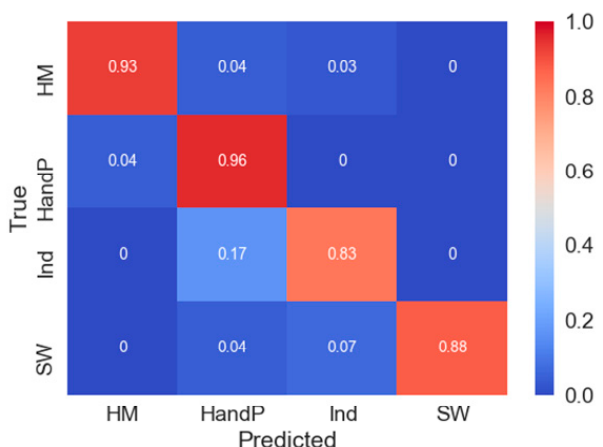
Figure 5. Application of CAM information with truncated dataset. Confusion matrix demonstrating retained classification ability of the truncated dataset, following truncation of the 4-SW dataset from 1002 in length to 400 (where the first 502 and last 100 data points were removed).